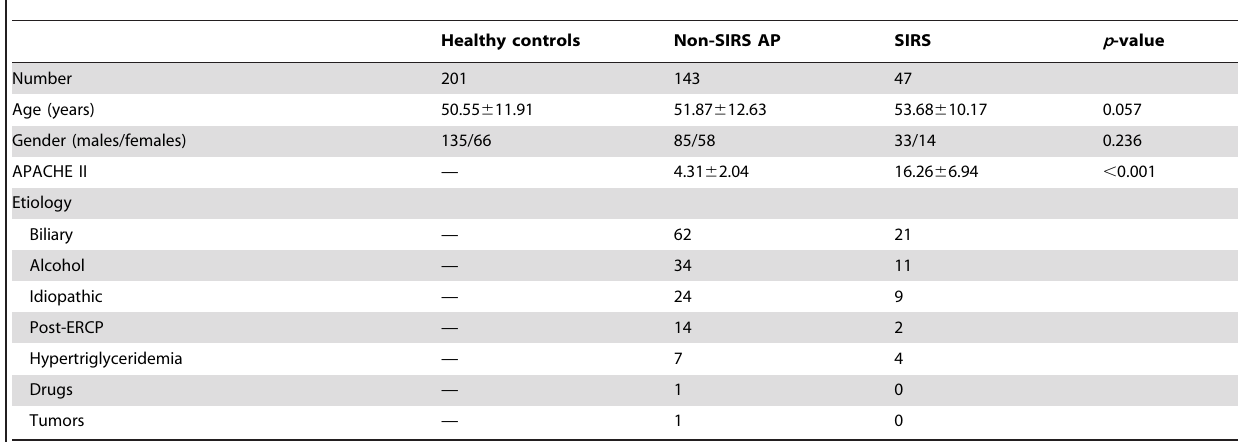
Table 1. Demographics and clinical characteristics of all subjects.